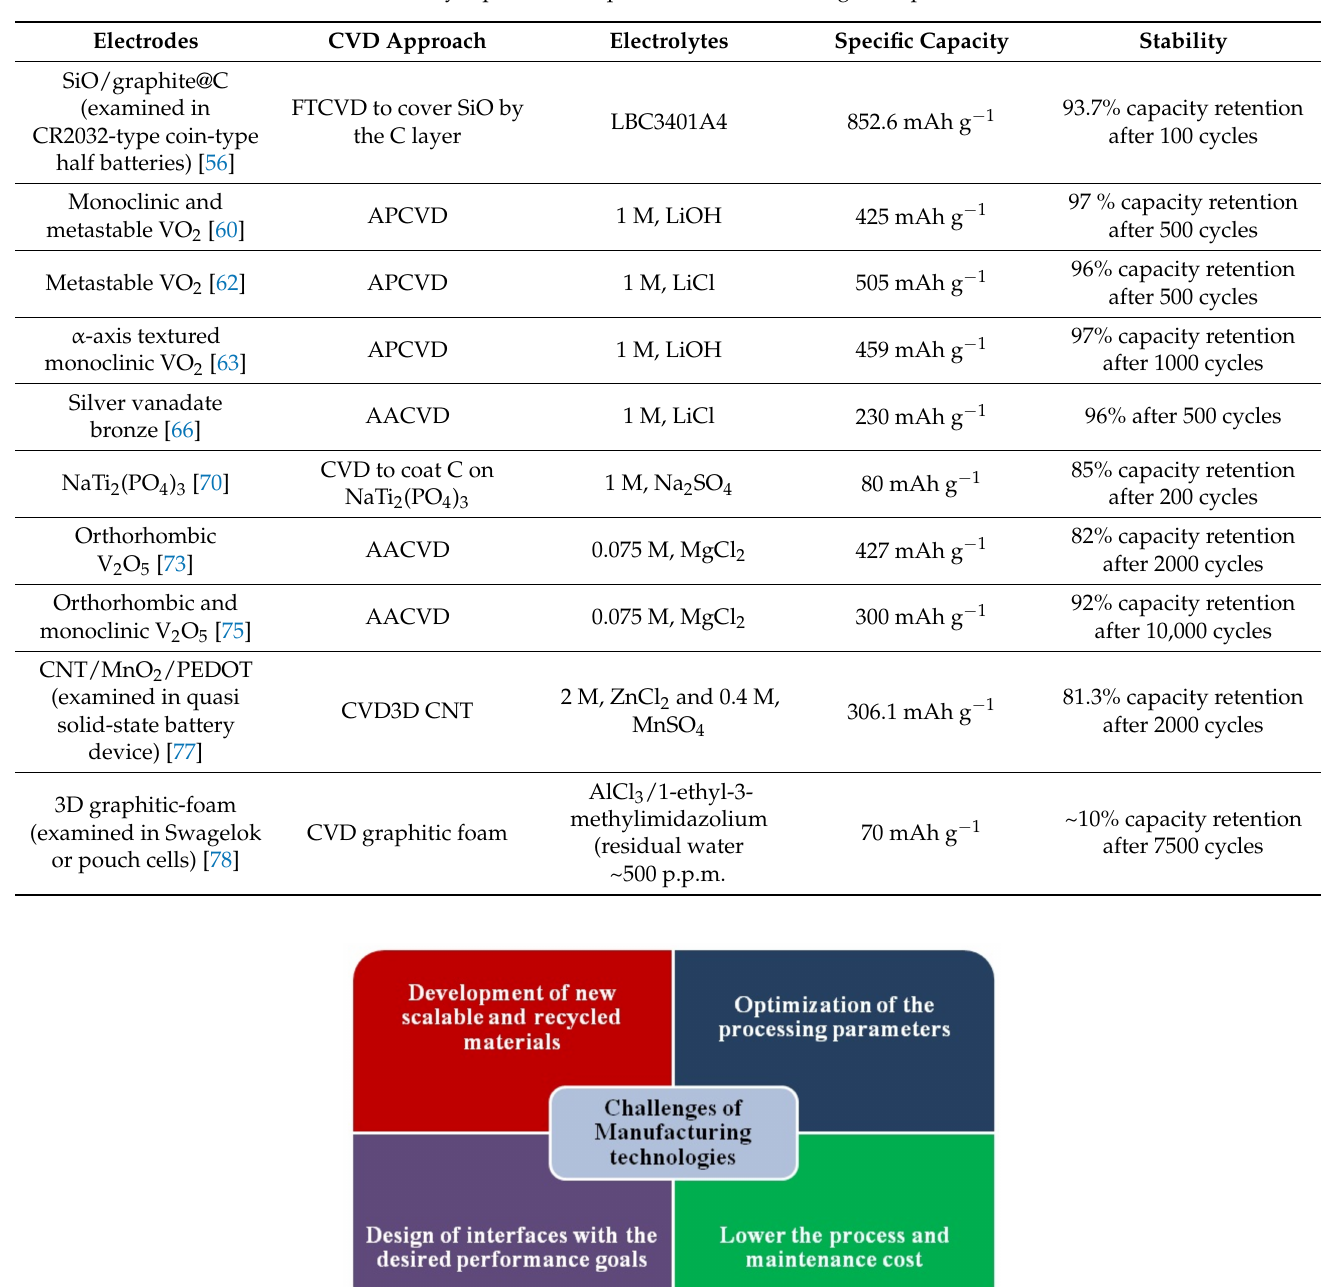
Table 2. A synopsis of the aqueous batteries utilising CVD processes.